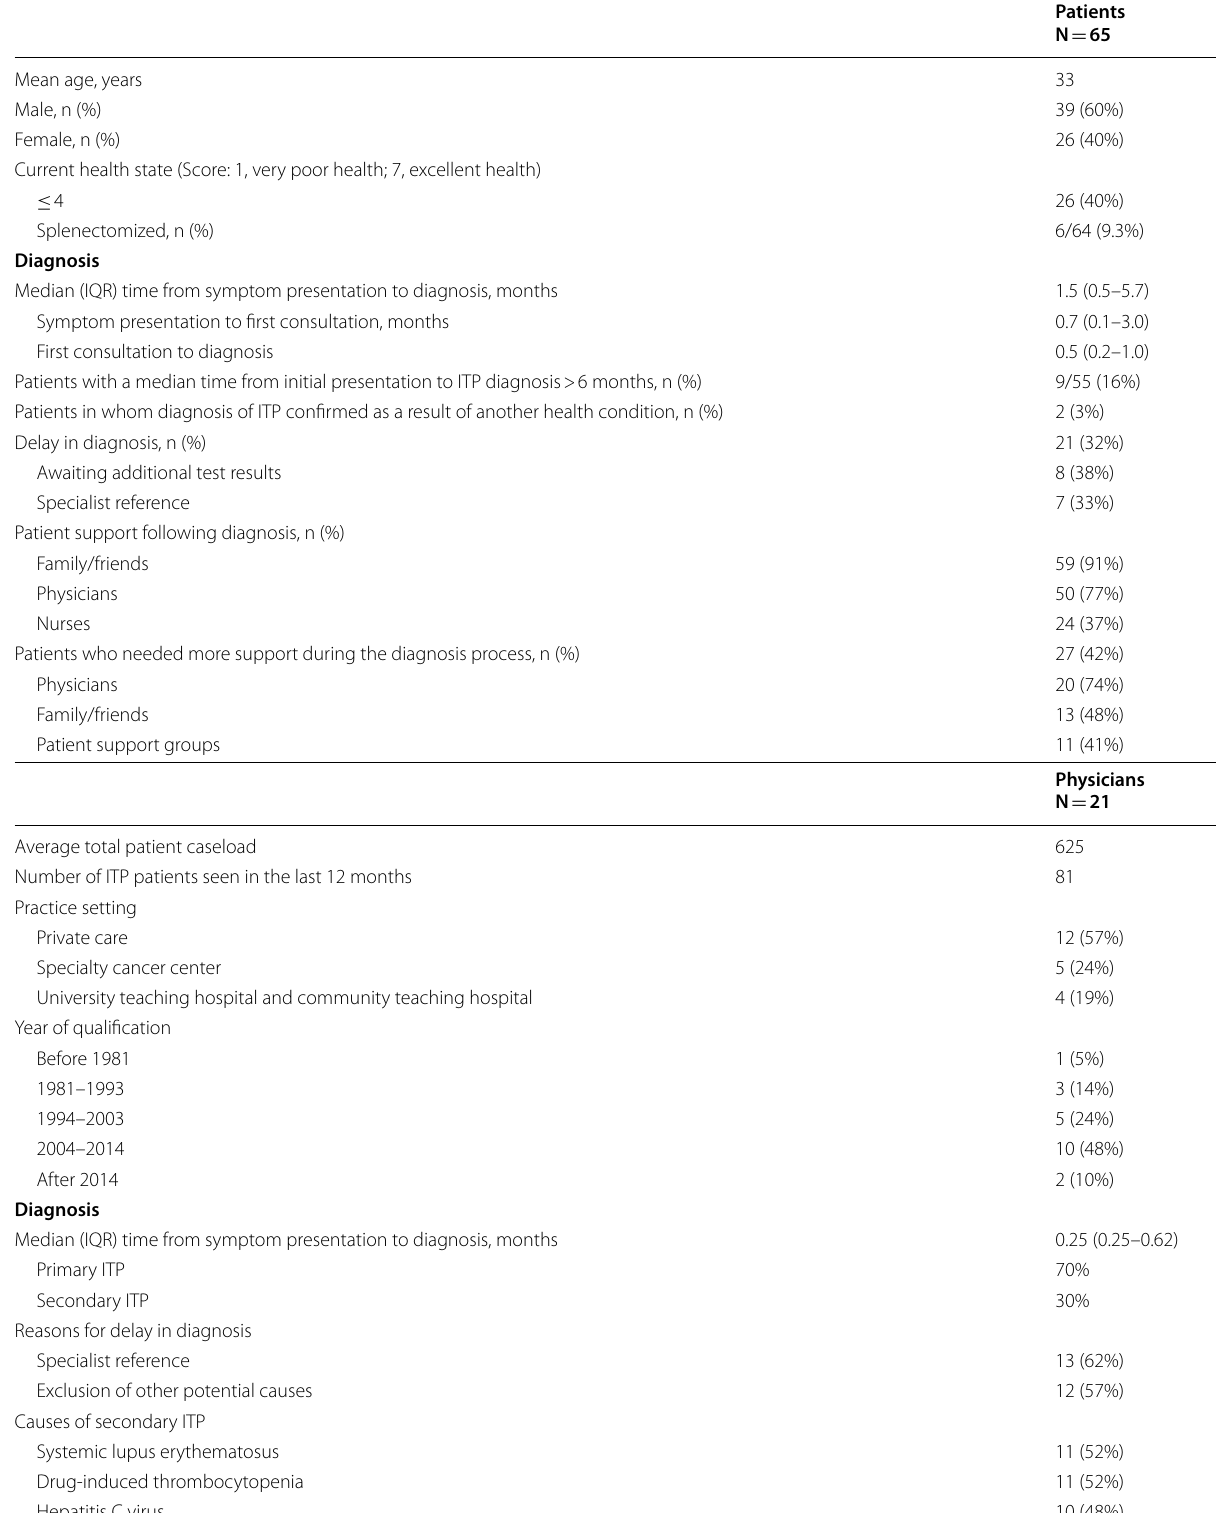
Table 1 Patient/physician demographic characteristics and patient diagnostic pathways